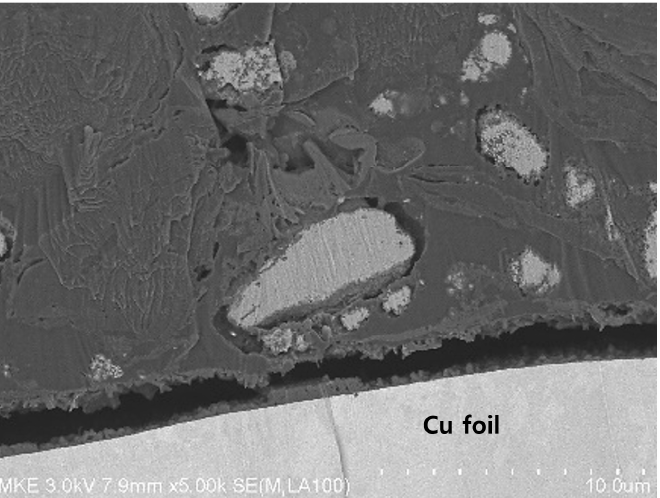
Figure 12. Cross-sectional SEM image of the N-Si alloy anode inside the PFC, obtained after 600 cycles. The results of the rate performance evaluation of the PFCs are shown in Figure